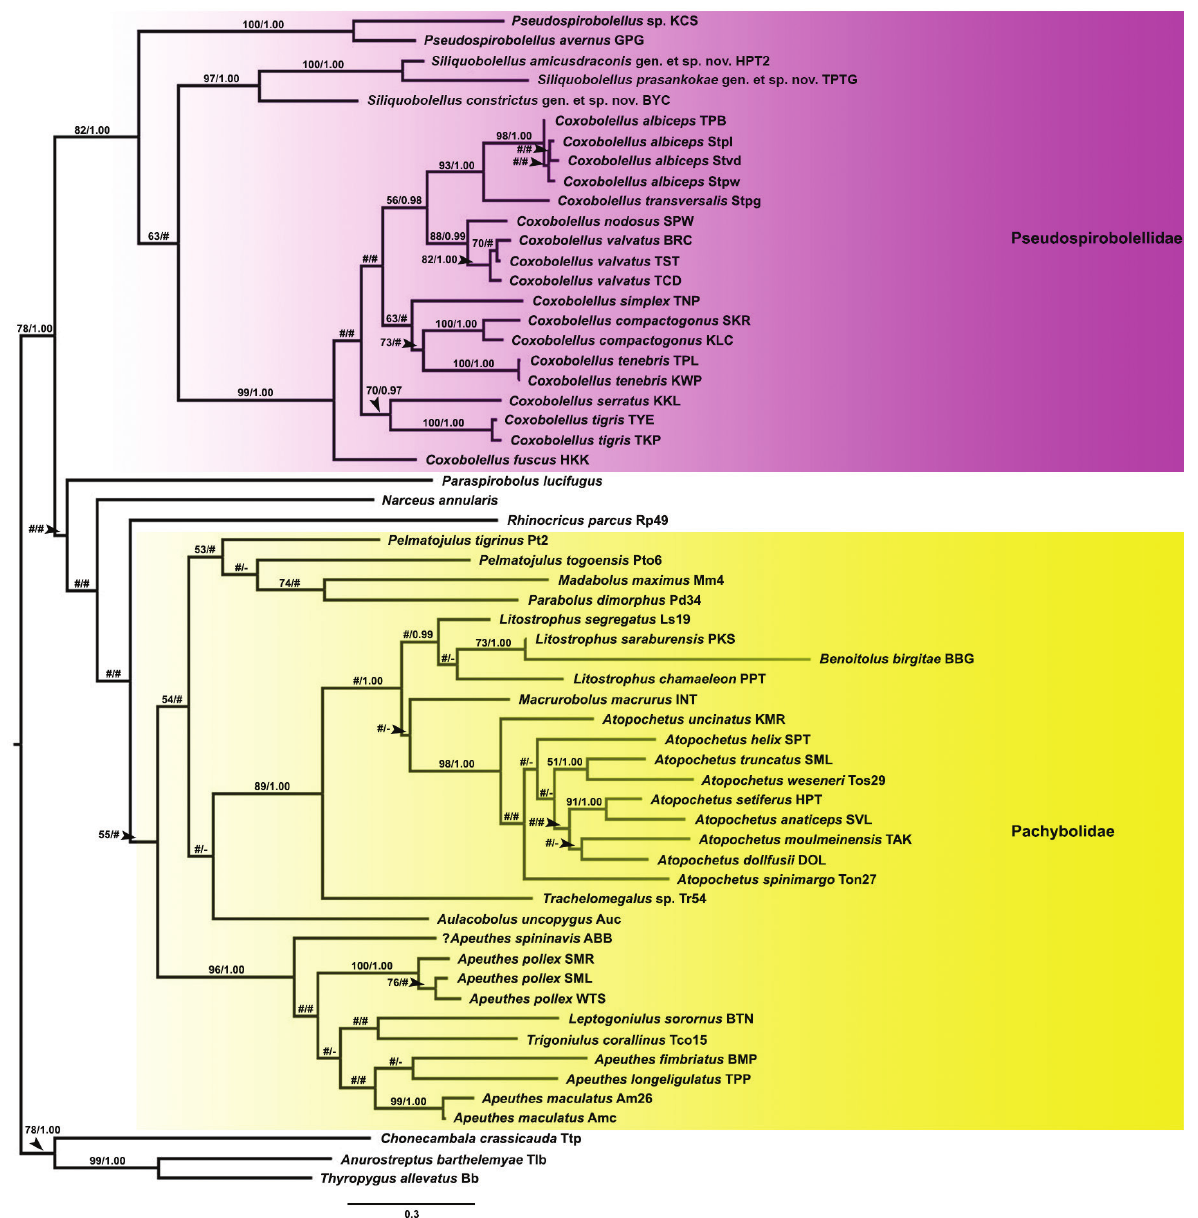
Figure 1. Phylogenetic relationships of Siliquobolellus gen. nov. and several other spirobolidan millipede taxa based on maximum likelihood analysis (ML) and Bayesian inference (BI) of a 660 bp COI gene fragment. Numbers at nodes indicate branch support based on bootstrapping (ML) / posterior probabilities (BI). Scale bar = 0.3 substitutions/site. # indicates branches with < 50% ML bootstrap support or < 0.95 posterior probability, - indicates non-supported branches. The colored areas mark the families Pseudospirobolellidae (minus Benoitolus ) (purple) and Pachybolidae (plus Benoitolus )